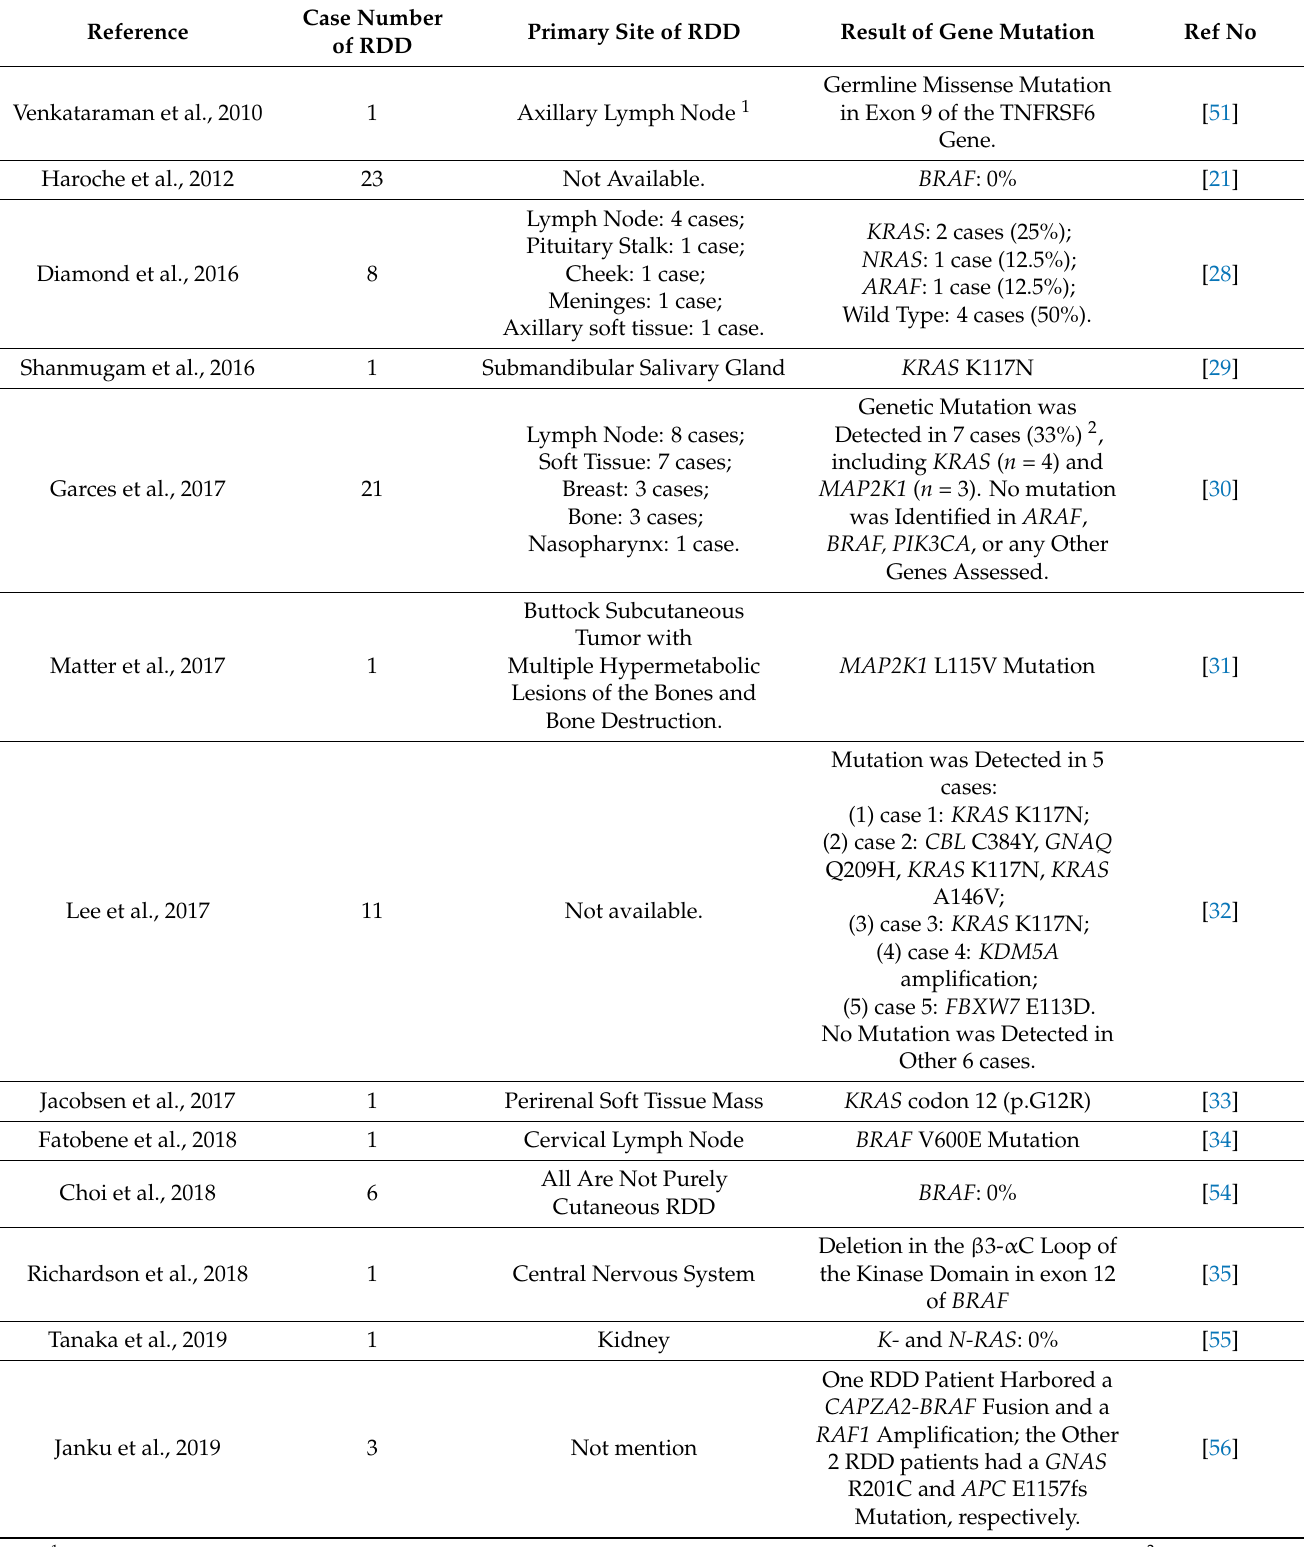
Table 3. The summary of genetic mutations described in